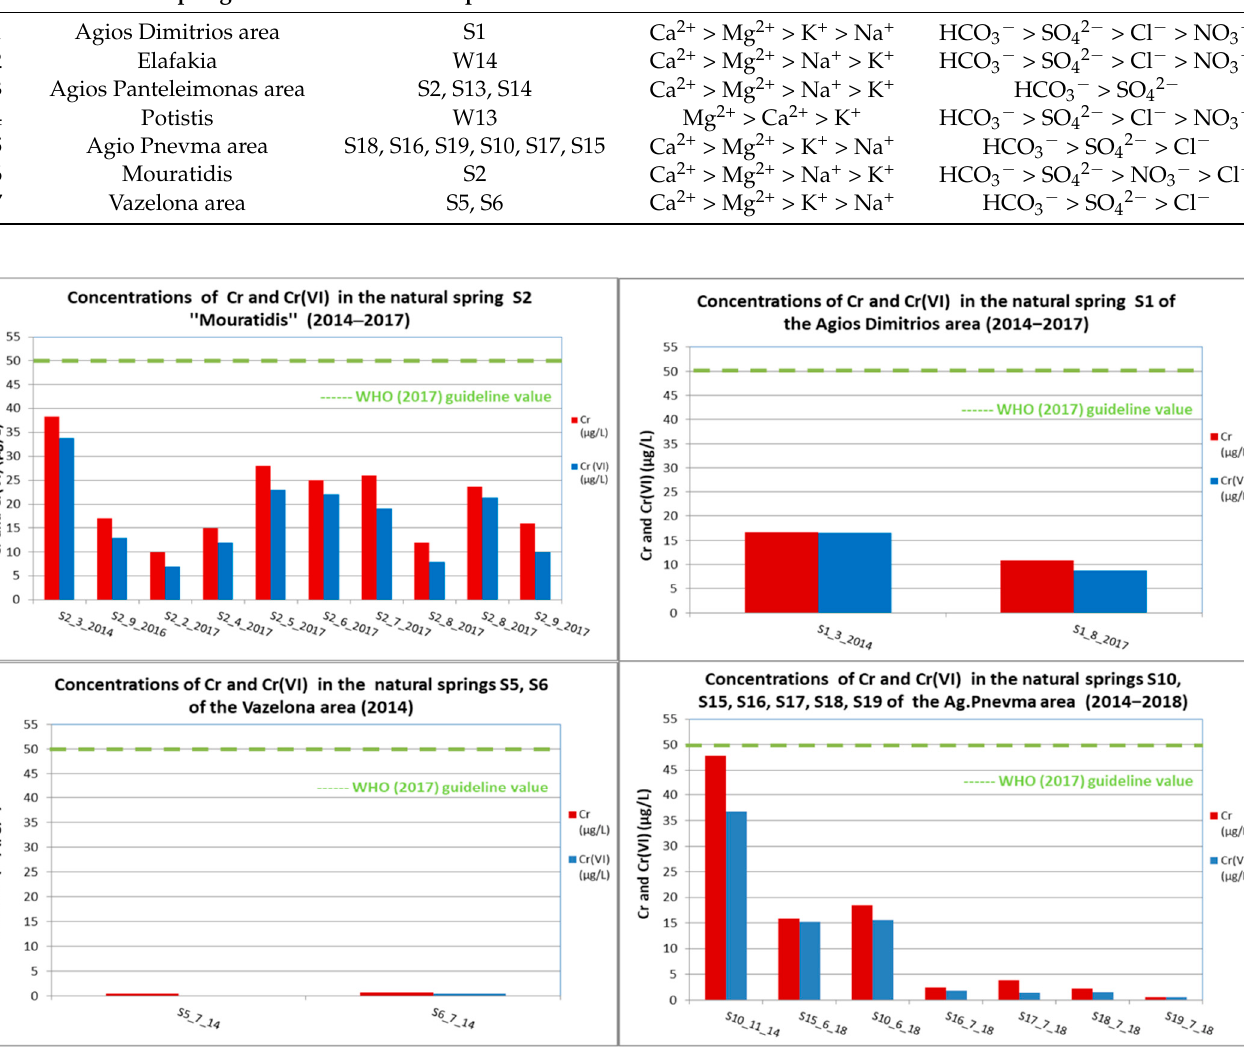
Figure 8. Concentrations of Cr and Cr(VI) in the natural springs of western Vermio Mt.